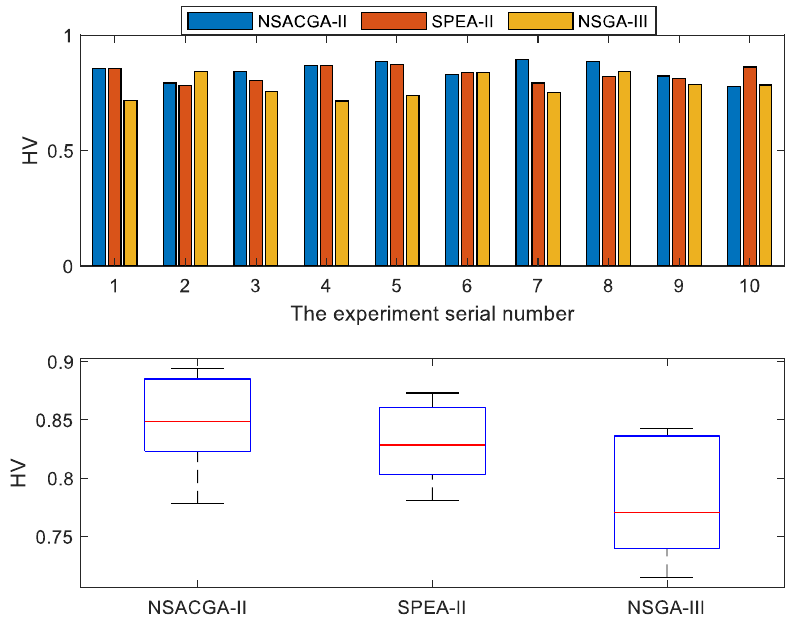
Figure 8. HV of NSACGA-II, SPEA-II and NSGA-III. Similarly, in order to have a more intuitive understanding of the distribution of SP values of each algorithm, a histogram and a boxplot are drawn in combination with the final SP values of the algorithm, as shown in Figure 9. Since the smaller the SP value, the better, from Figure 9, the distribution of the SP value of the NSACGA-II algorithm is the best. In terms of uniformity, the NSGA-II algorithm is still better than the SPEA-II algorithm, and even better than the NSGA-III